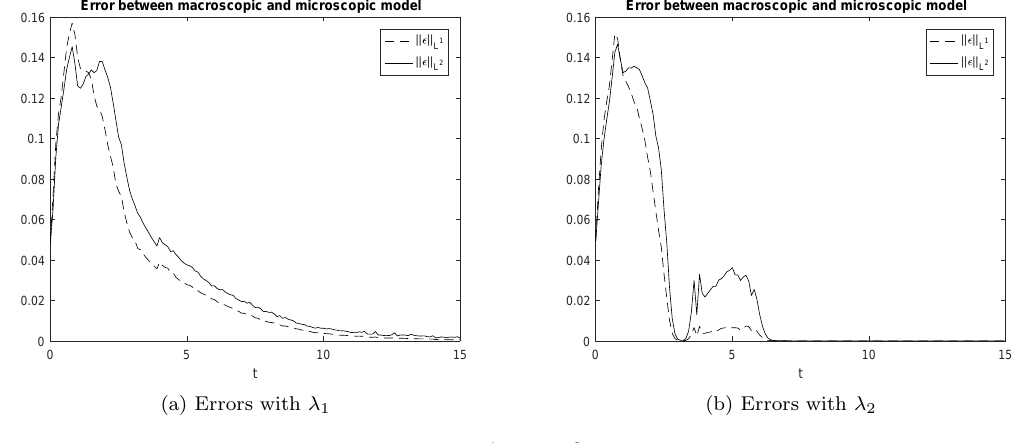
Figure 10: L 1 and L 2